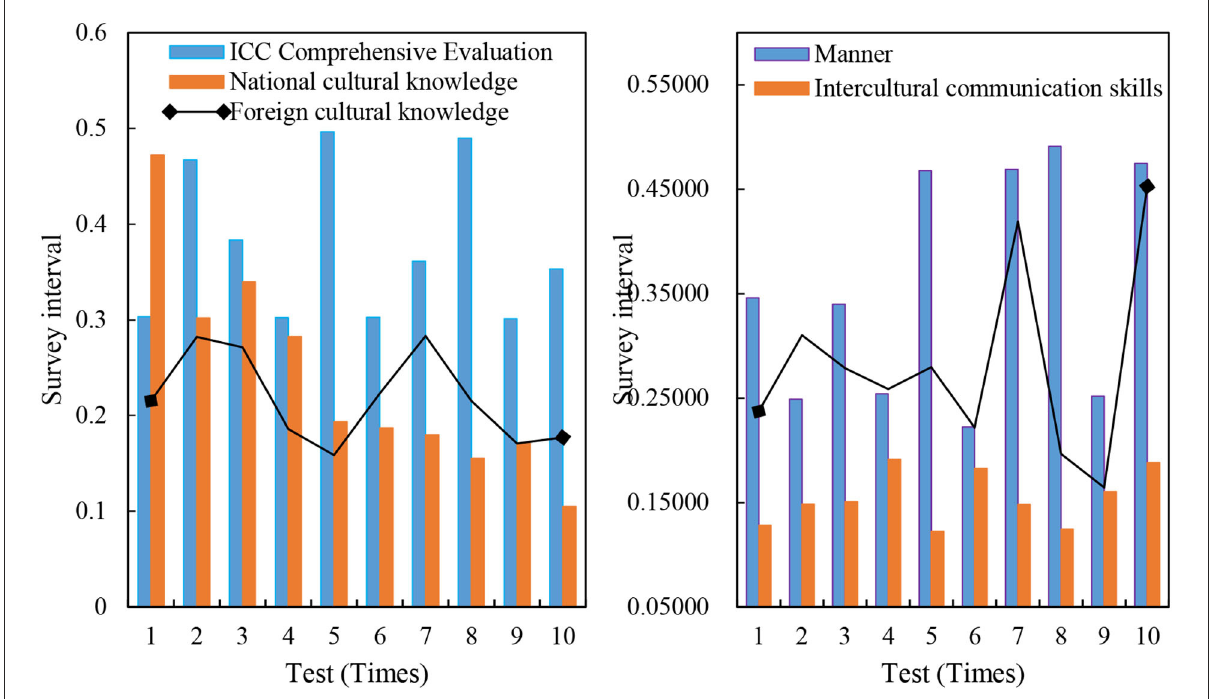
FIGURE5 Evaluation result with a score of 600 or more in CET-4.